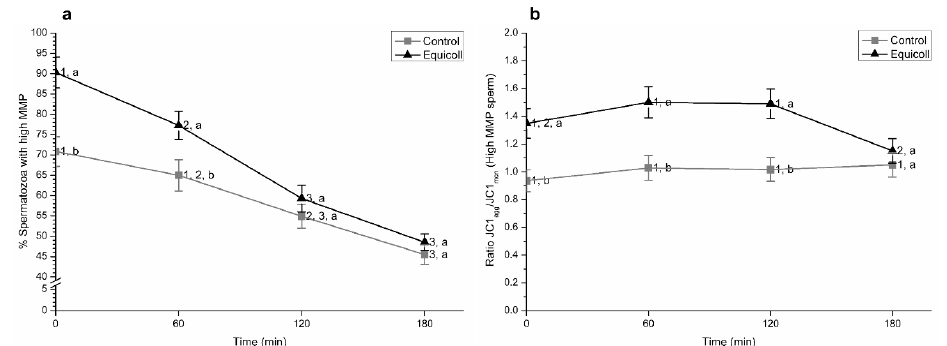
Figure 2. ( a ) Percentages of spermatozoa with high mitochondrial membrane potential (MMP) and ( b ) ratios between JC1 agg and JC1 mon of the sperm population with high MMP in control